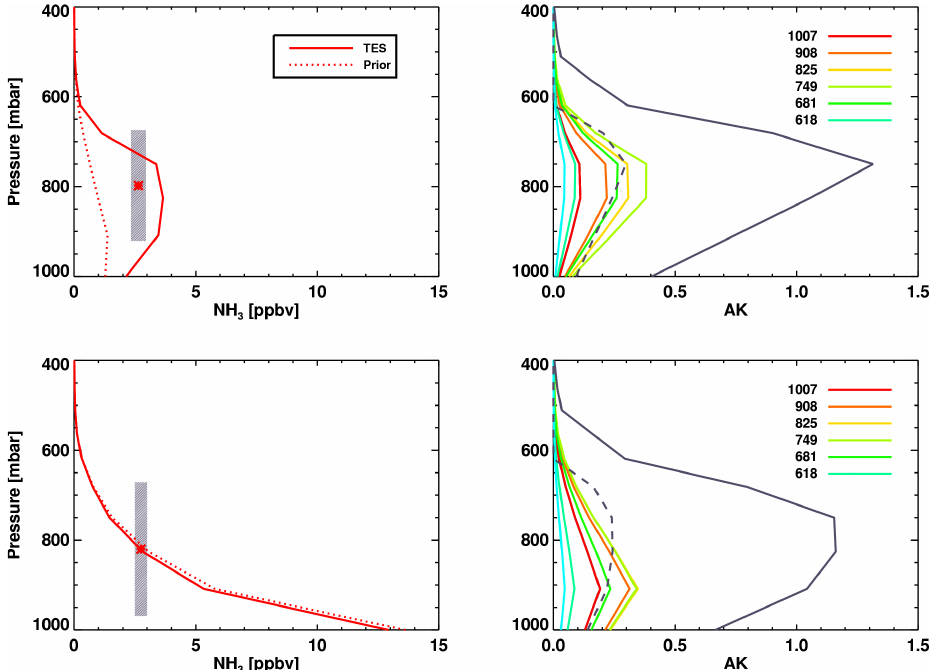
Fig. 8. Differences in retrieved profile shape due to different a priori selection choices: moderate (top) and polluted (bottom). In the left panels the solid curve is the retrieved profile, dashed curve is a priori, red star indicates RVMR at the RVMR pressure level, while the vertical extent of the grey bar indicates the range covered by the RVMR and the width shows the estimated error due to instrument noise. In the right panels the colored curves are the rows of the averaging kernel (AK), the solid grey curve is the sum of the rows of the AK, and the dashed grey curve is weighting function that maps the retrieved profile into the RVMR.